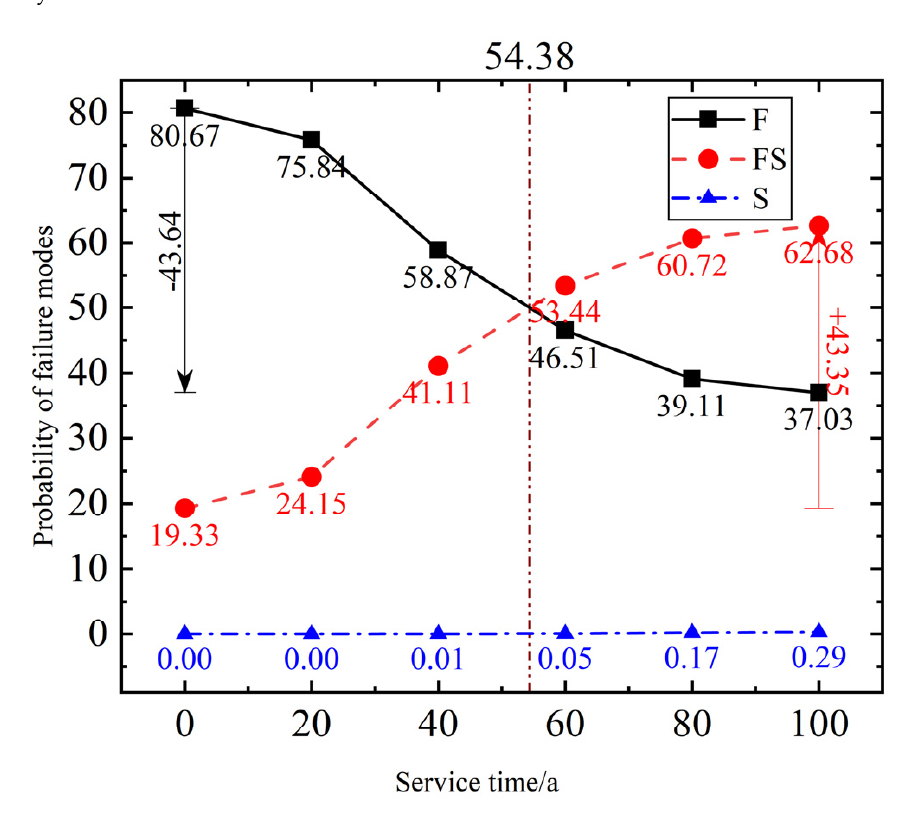
Table 6. Failure modes of bridge piers over 100 years of service.